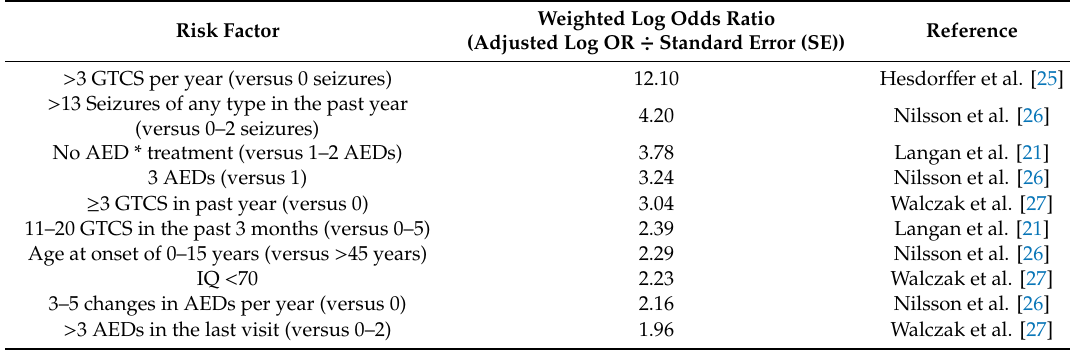
Table 3. Principal risk factors for SUDEP (adapted from Reference